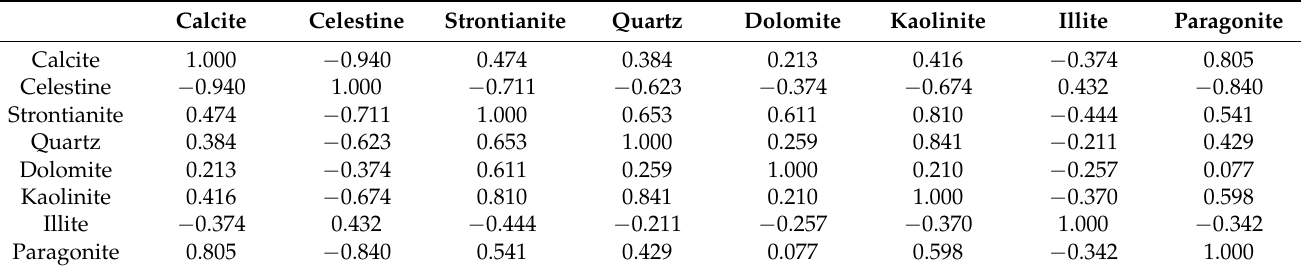
Table 5. Correlation analysis between phase determined by XRD. Significant correlations ( p < 0.05) are in bold